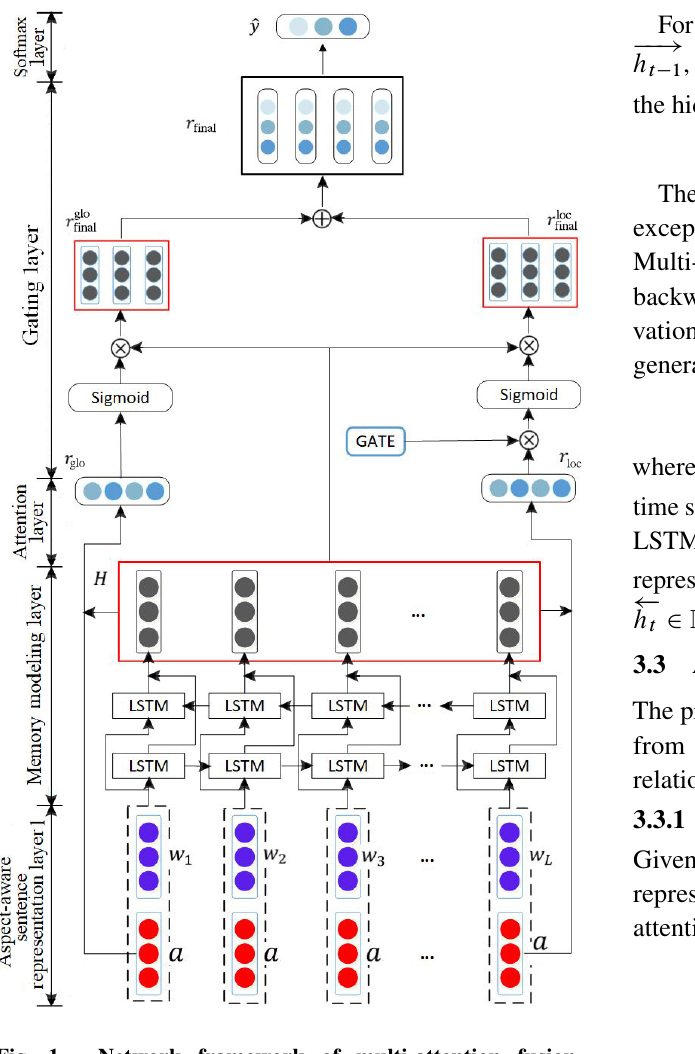
Fig. 1 Network framework of multi-attention fusion